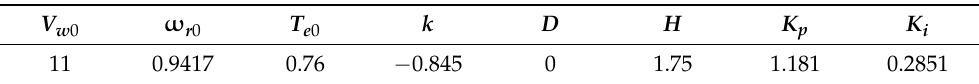
Table 1. System constants and proportional-integral (PI) controller gains under the steady-state operating point.